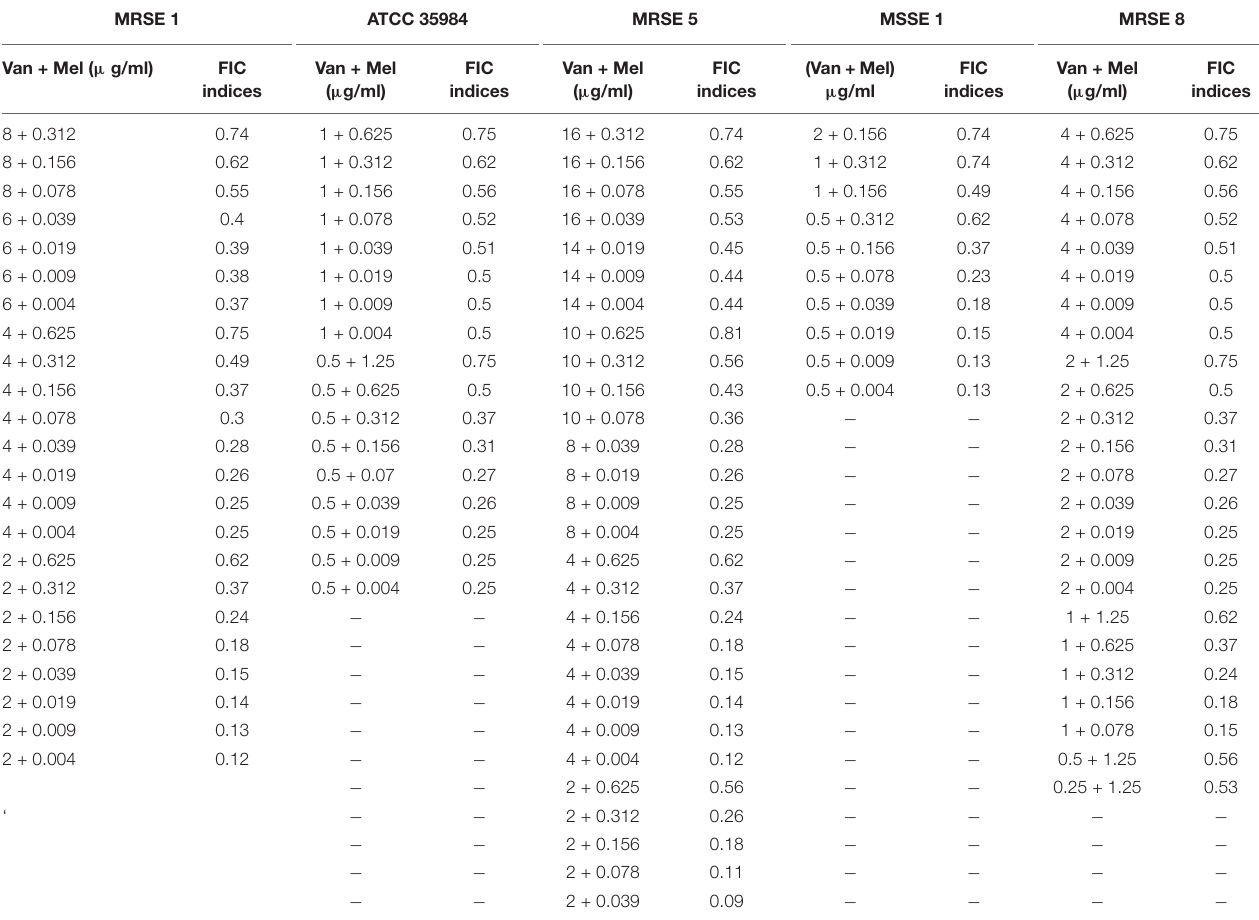
TABLE 4 | The best synergistic concentrations of Vancomycin-Melittin based on MIC against selected